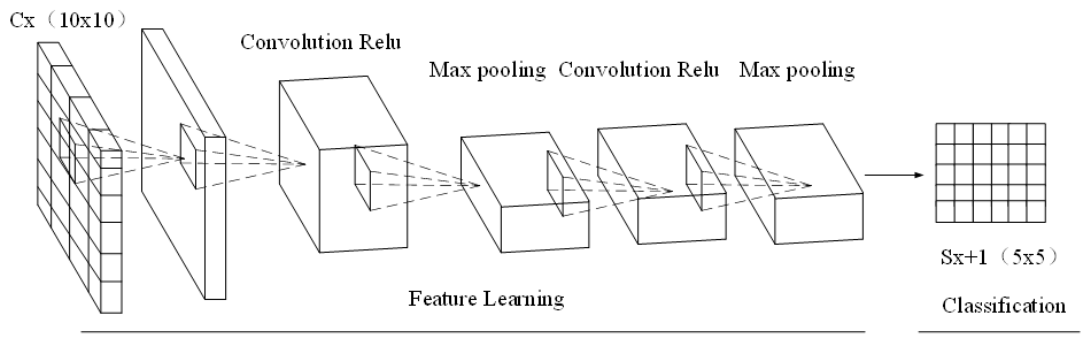
Figure 4. Structure of the deep learning collection layer.